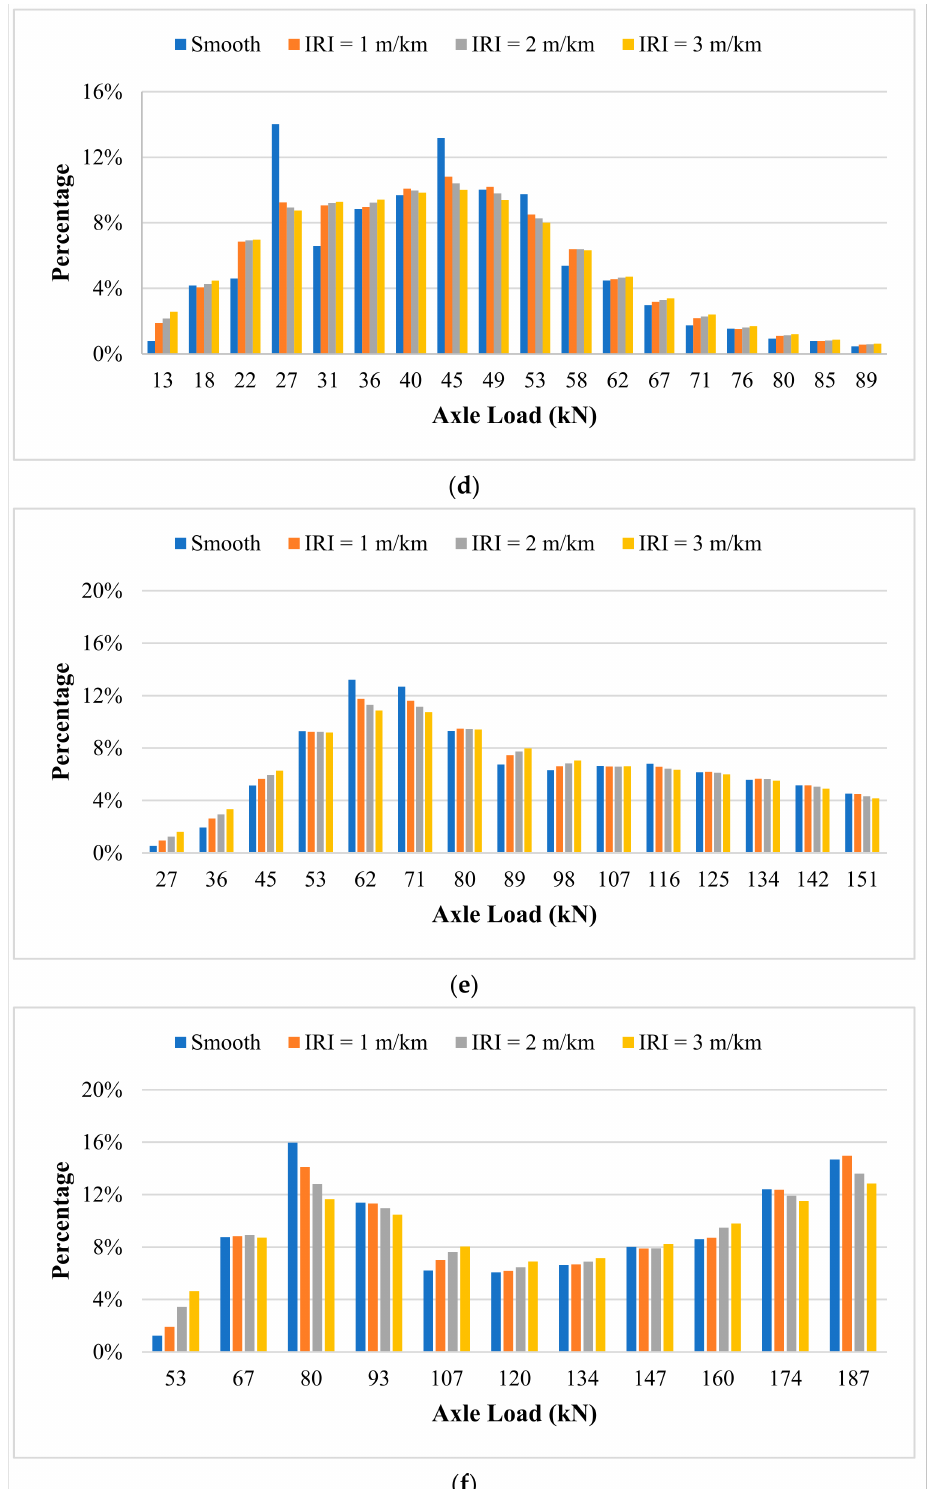
Figure 8. Static and dynamic axle load spectra of non-overweight traffic: ( a ) single axle (major); ( b ) tandem axle (major); ( c ) tridem axle (major); ( d ) single axle (minor); ( e ) tandem axle (minor); and ( f ) tridem axle